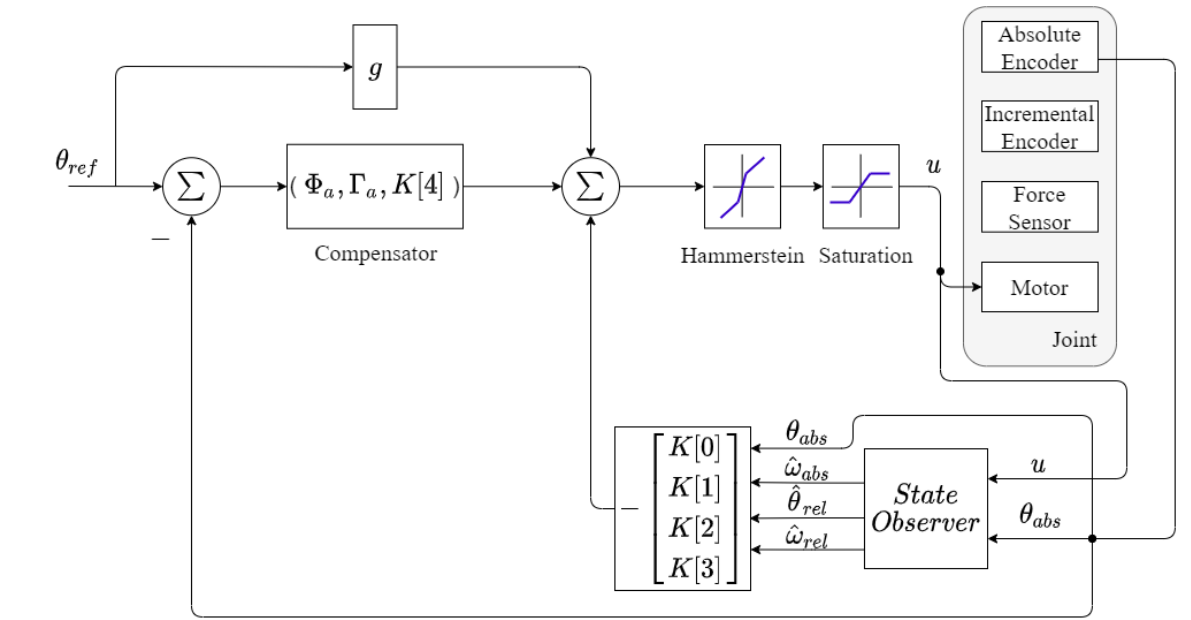
Figure 8. State-space controller block diagram non-rigid